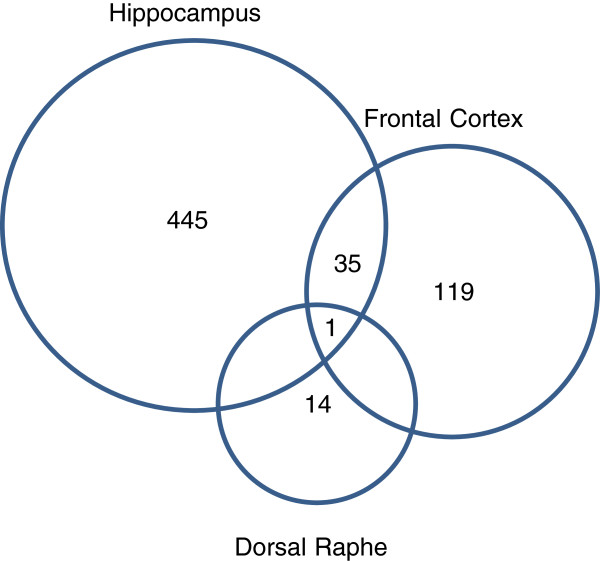
Venn-diagram representation of significantly altered mRNAs. Venn-diagrams showing the number of significantly (minimum probability of positive log ratio (MinPplr) < 0.001) up- or downregulated genes in the hippocampus (HC), frontal cortex (FC) and dorsal Raphe (DR) of Dark Agouti (DA) rats 3 weeks after a single-dose of 3,4-methylenedioxymethamphetamine (MDMA) (15 mg/kg, intraperitoneally). Altogether 615 genes’ showed altered expression, 481, 155, 14 genes in the HC, FC, DR regions, respectively. Among them only 1 genes’ expression altered significantly in all three regions and 36 genes differed significantly compared to saline controls in both the FC and HC groups. See text for further details.